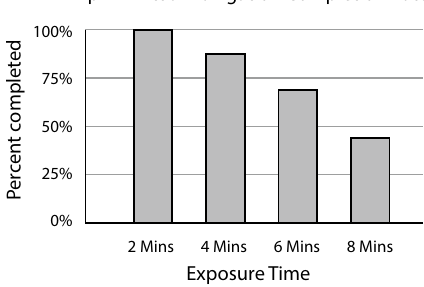
Fig. 3 Percent of subjects who completed each of the virtual navigation blocks in Experiment 1. The procedure was stopped if subjects reported more than mild motion sickness symptoms (>6 on MISC scale). Less than half of the subjects were able to complete